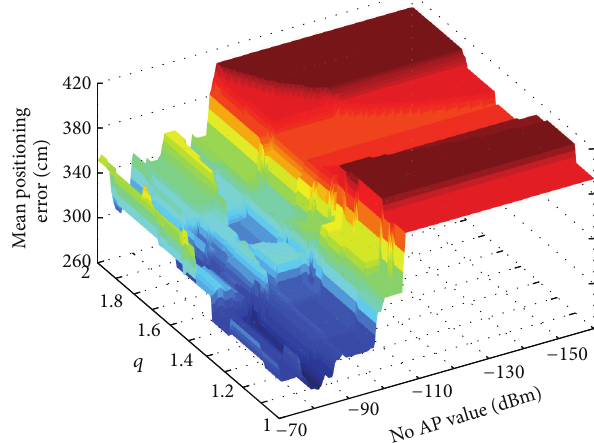
Figure 4: Mean positioning error dependence of the signal space distance parameters 𝑞 and 𝑛𝑜𝐴𝑃 .